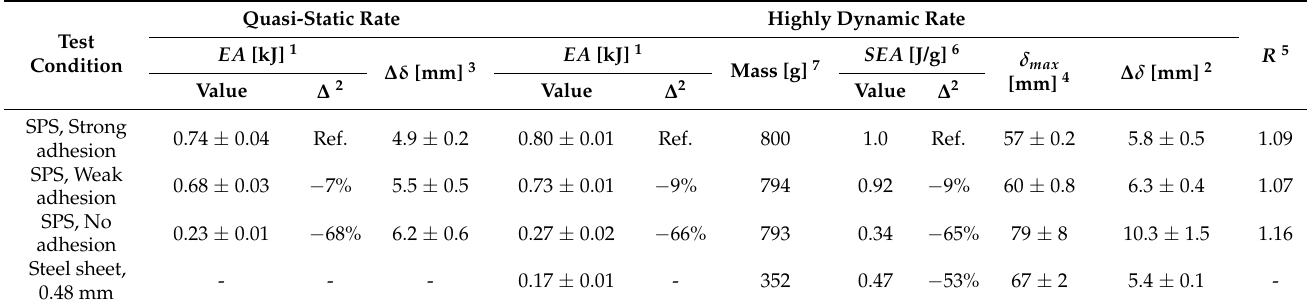
Table 4. Summary of the three-point bending test